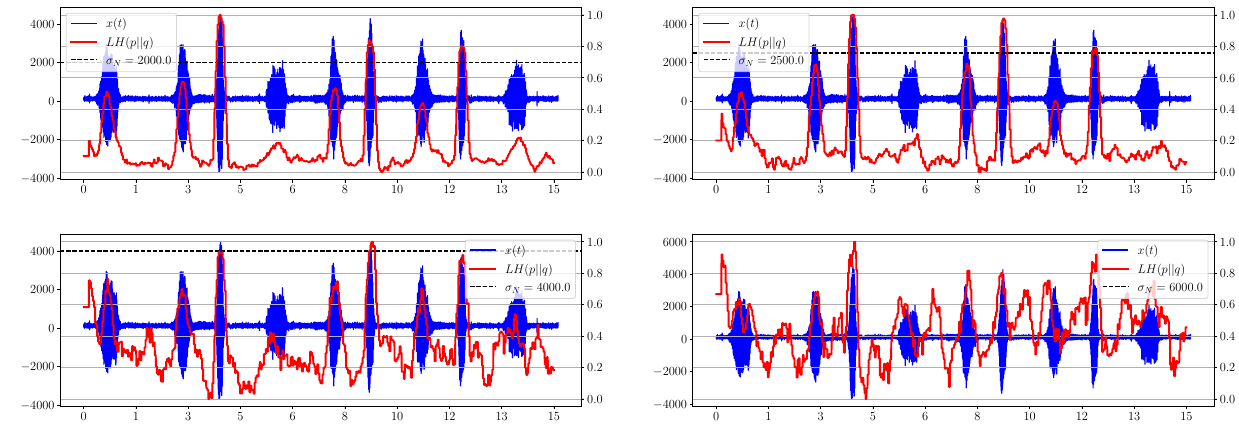
Figure 2. Graphs of LH ( pq ) for different levels of added noise.